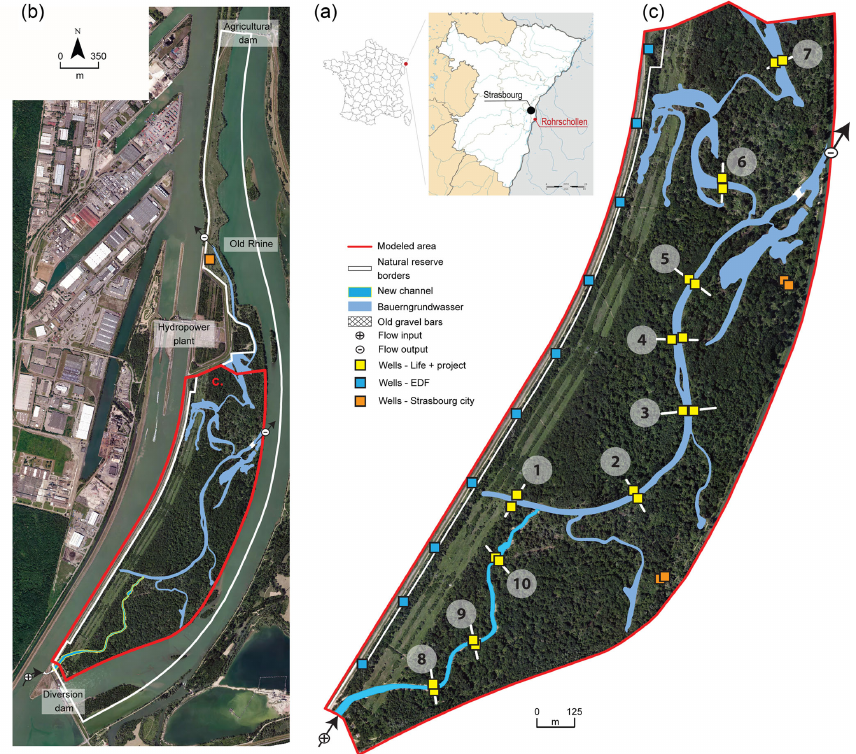
Figure 1. (a) Location of the studied area (France), (b) aerial view of Rohrschollen Island, and (c) network of hydrologic response measure- ments (mainly hydraulic heads and water